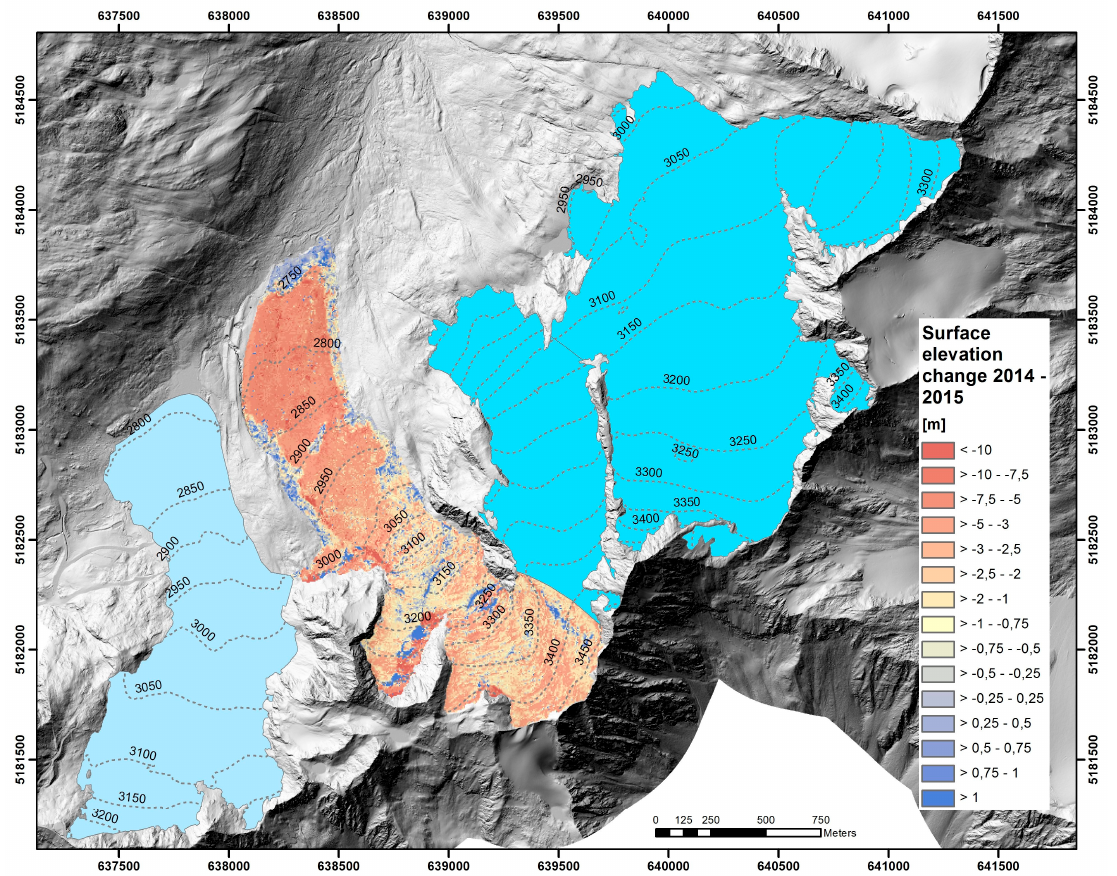
Figure 12. One-year surface elevation change of the investigated part of Hochjochferner autumn 2014–autumn 2015. UTM 32 N.